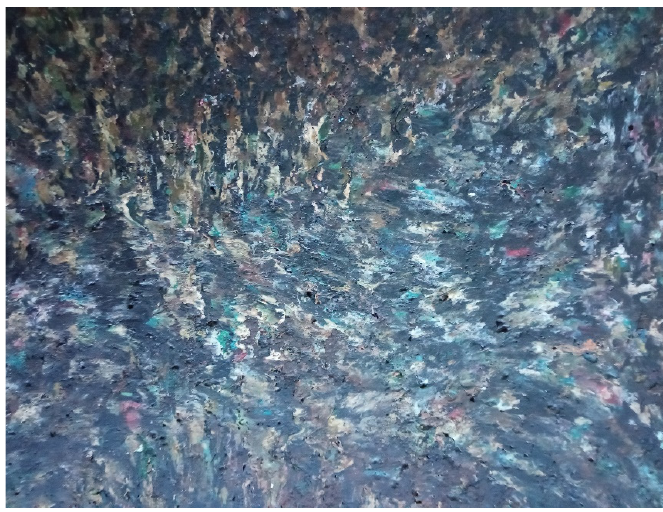
Figure 4. Plate obtained in the press moulding process.